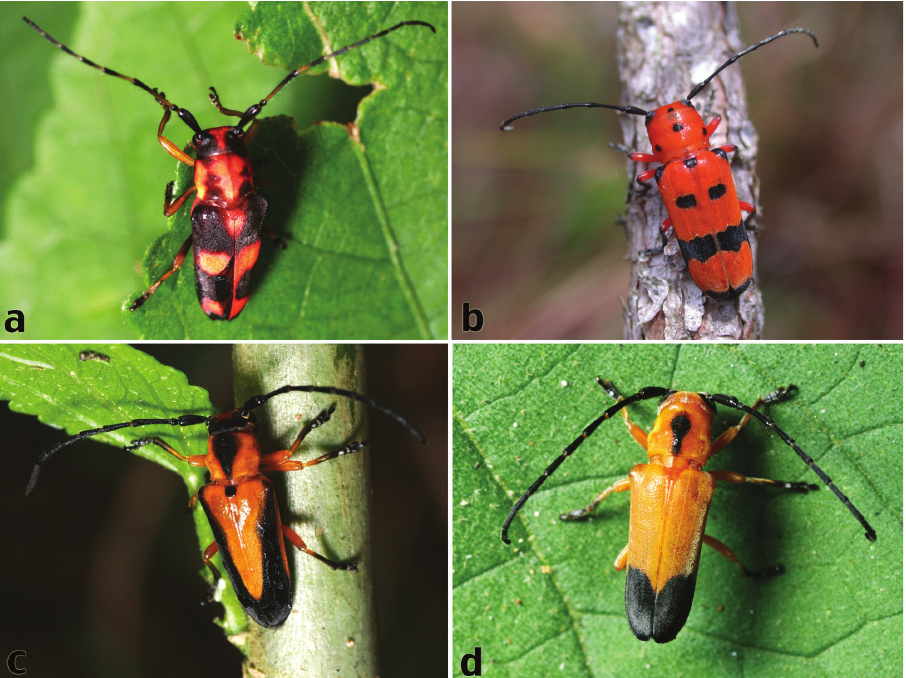
Figure 1. Live habitus photos of Hispaniolan Hemilophini: a Oedudes anulatus Lingafelter, sp. n. (La Vega Province) (photo by Rick Stanley) b Calocosmus magnificus Fisher (Pedernales Province) (photo by Kelvin Guerrero) c Calocosmus nigritarsis , unusual morphotype (La Vega Province) (photo by Rick Stanley) d Calocosmus nigritarsis , typical morphotype (Independencia Province) (photo by Gino